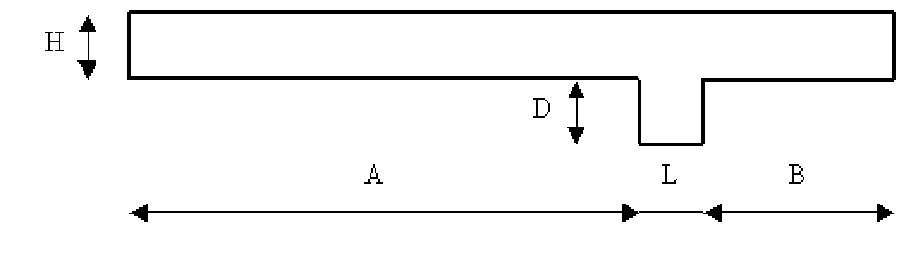
Figure 1. Geometry under investigation.